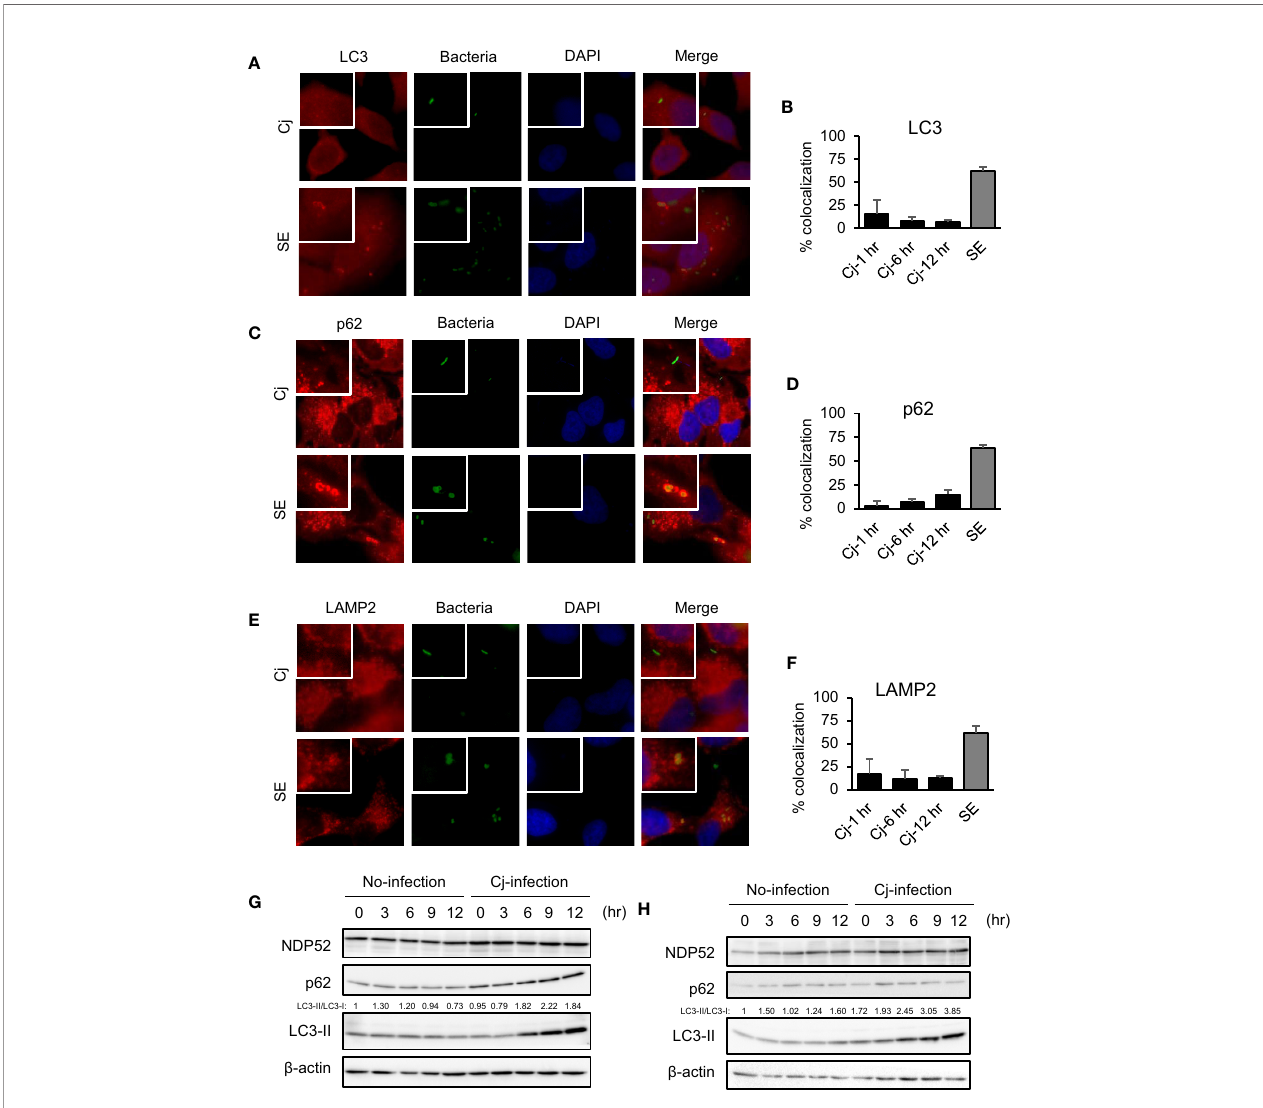
FIGURE 1 | The indication of autophagy, and localization of autophagosomes/lysosomes and pathogens in C. jejuni infection. (A, C, E) Representative immuno fl uorescence images of HeLa cells infected with S. Enteritidis (SE) for 1 h or C. jejuni (Cj) for 6 h. S. Enteritidis and C. jejuni was stained with 10 ng/ml 5(6)- Carboxy fl uorescein diacetate (CFDA) solution, and infected to HeLa cells. Cells were immunostained by anti-LC3 (A) , p62 (C) , and LAMP2 (E) antibody and DAPI, and observed by Keyence BZ-X700 fl uorescence microscope. (B) Intracellular bacteria which co-localized with LC3 were quanti fi ed. Co-localization rate was determined at 1 h p. i. (Cj-1 h), 6 h p. i. (Cj-6 h), and 12 h p. i. (Cj-1 hr) in (C) jejuni infection, and 1 h p. i. (SE) in S . Enteritidis infection. Cj-1 h: 15.93 ± 14.33% of colocalization; n = 36, Cj-6 h: 7.88 ± 4.30% of colocalization; n = 55, Cj-12 h: 6.54 ± 2.38% of colocalization; n = 94, and SE: 62.40 ± 4.16% of colocalization; n = 186. Sample number indicated the sum of 3 independent experiments. (D) Intracellular bacteria which co-localized with p62 were quanti fi ed. Cj-1 h: 3.03 ± 5.25% of colocalization; n = 37, Cj-6 h: 7.35 ± 3.35% of colocalization; n = 59, Cj-12 h: 15.13 ± 5.05%; 12 h p. i. of colocalization; n = 117, and SE: 64.25 ± 2.50% of colocalization; n = 191. Sample number indicated the sum of 3 independent experiments. (F) Intracellular bacteria which co-localized with LAMP2 were quanti fi ed. Cj-1 h: 16.67 ± 16.67% of colocalization; n = 35, Cj-6 h: 11.21 ± 10.22% of colocalization; n = 55, Cj-12 h: 15.13 ± 5.05%; 12 h p. i. of colocalization; n = 96, and SE: (61.72 ± 6.99% of colocalization; n = 115. Sample number indicated the sum of 3 independent experiments. (G) HeLa cells were infected with C. jejuni NCTC 11168 up to 12 h and detected autophagy-related proteins, NDP52, p62/SQSTM, LC3 by Western blotting. (H) . Caco-2 cells were infected with C. jejuni and detected autophagy-related protein